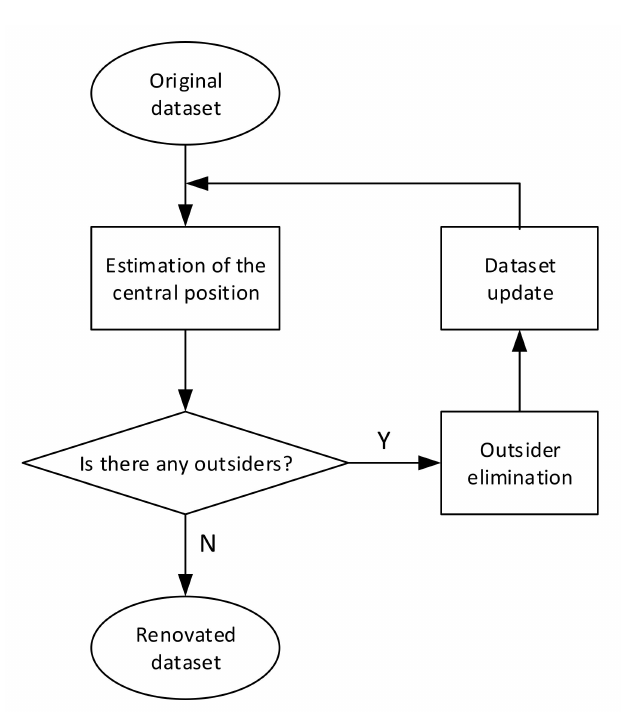
Figure 5. The process of improving the training